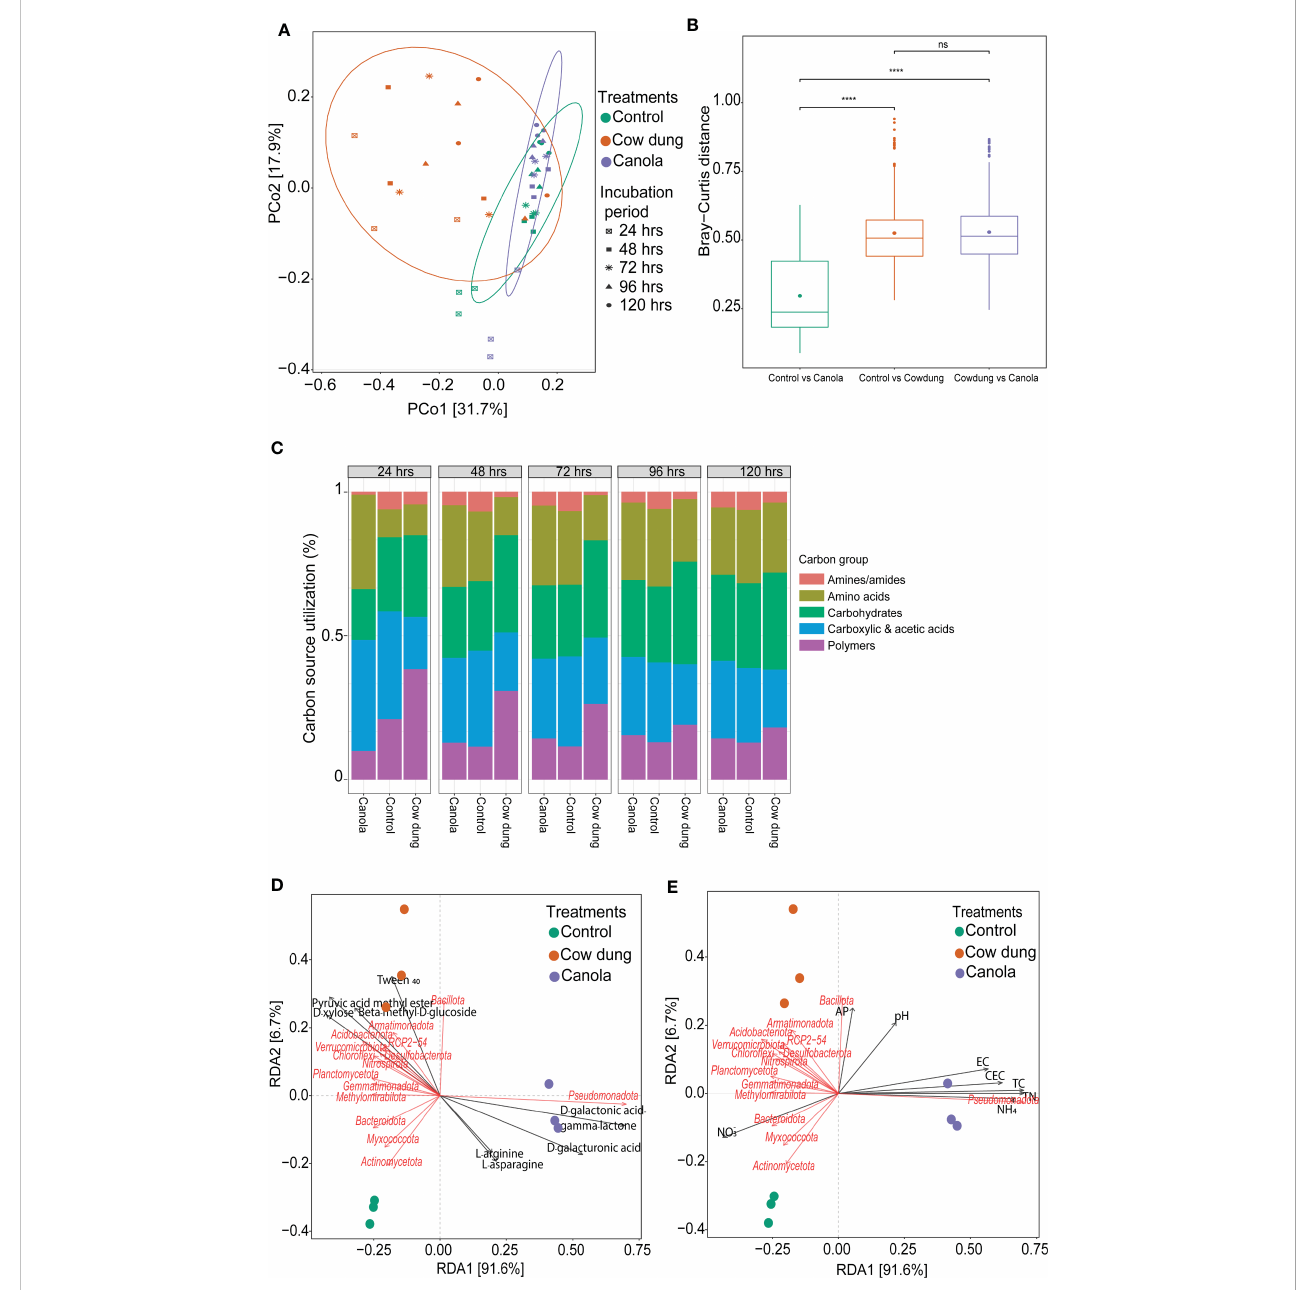
FIGURE 5 Effects of soil amendments on soil chemical properties, microbial communities, and their metabolic activities. PCOA plot showing the community-level physiological pro fi ling using Biolog EcoPlates with 31 different carbon sources at different incubation periods (A, B) . Relative carbon source utilization (%) (C) . Distance-based redundancy analysis (dbRDA) based on Bray-Curtis distance displaying the relationship of the soil bacterial communities with metabolic activities (D) and soil chemical properties (E) as indicated by the angles and projection of arrows. The length of the arrows represents the contribution of each soil chemical parameter to the variation in the bacterial community structure. Refer to Table 1 for soil chemical property